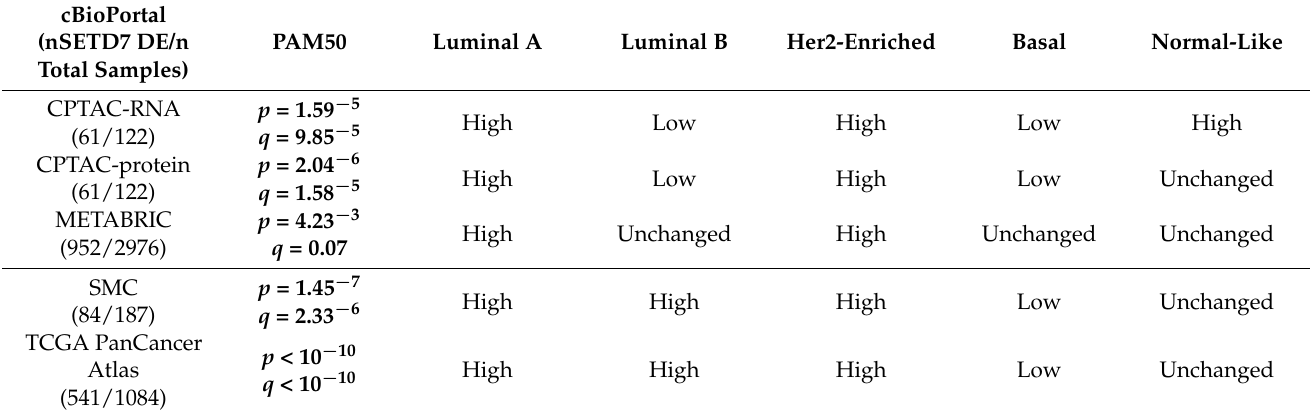
Table 1. SETD7 expression per subtype. Significant values are highlighted in bold. Chi-squared test p -value and Benjamini–Hochberg FDR correction q -value. NA—not available; nSETD7 DE—number of samples with differentially expressed SETD7; nTotal—total number of samples.